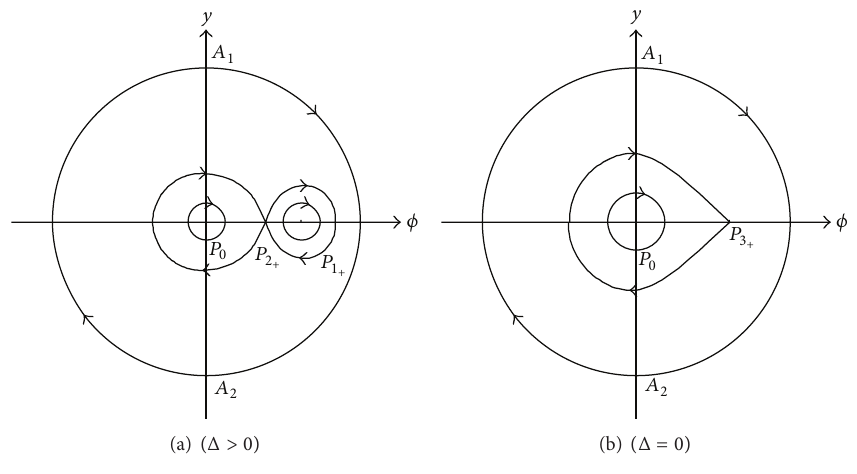
Figure 14: ( 𝛽 > 0 , 𝑎 < 0 , 𝑏 > 0 , 𝑐 < 0 ).